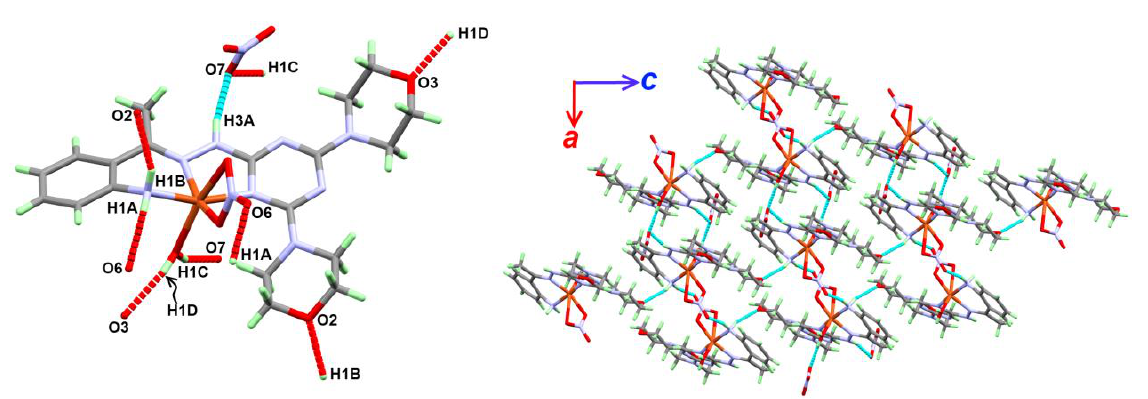
Figure 4. The hydrogen bond contacts ( left ) and packing along the ac plane ( right ). Table 2. The hydrogen bond parameters of complexes 1 and 2 .